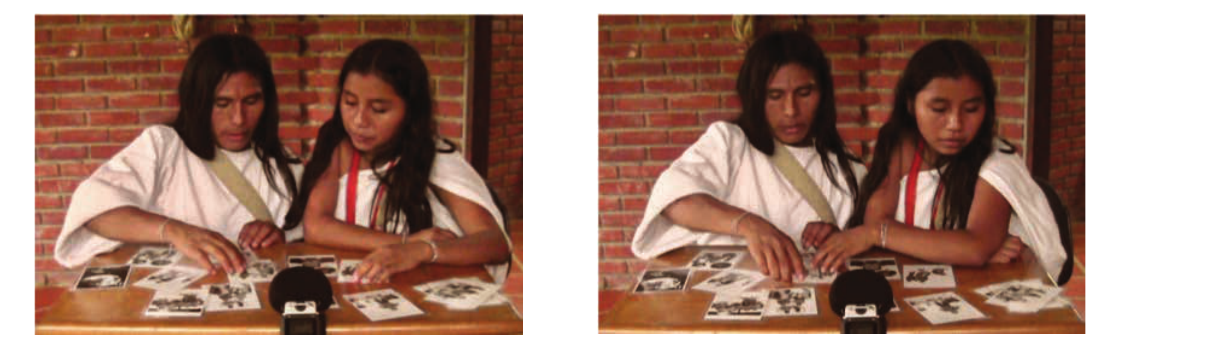
Figure 1a: Use of hẽ hié. Figure 1b: Use of twẽ